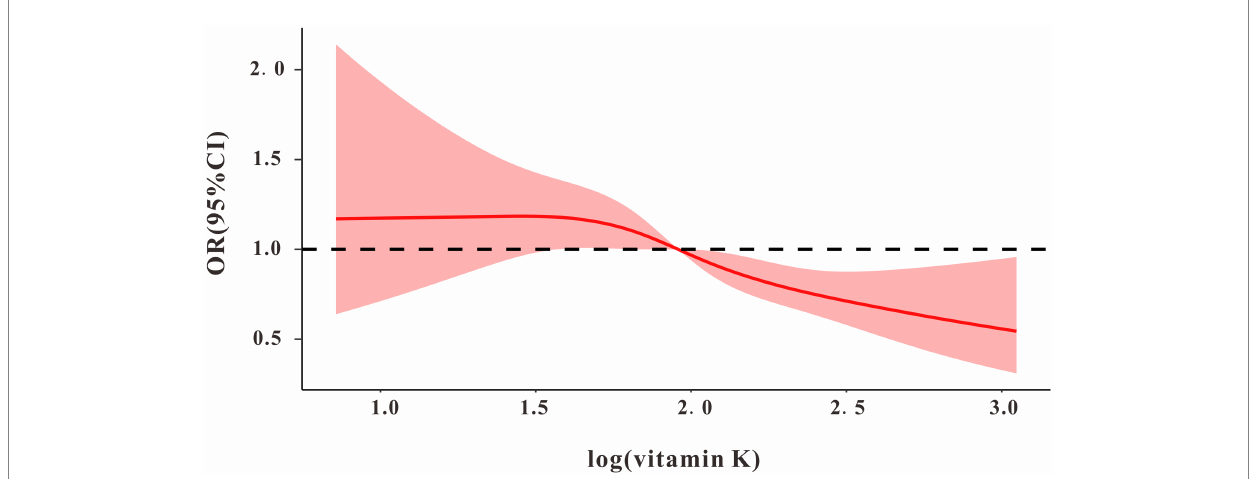
FIGURE 1 The dose–response relationship between log vitamin K and MAFLD. Model adjusted for age, sex, race, body mass index, education, smoking, alcohol, aspartate aminotransferase, alanine Aminotransferase, minutes sedentary activity, energy, HEI-2015; diabetes mellitus; hypertension, and